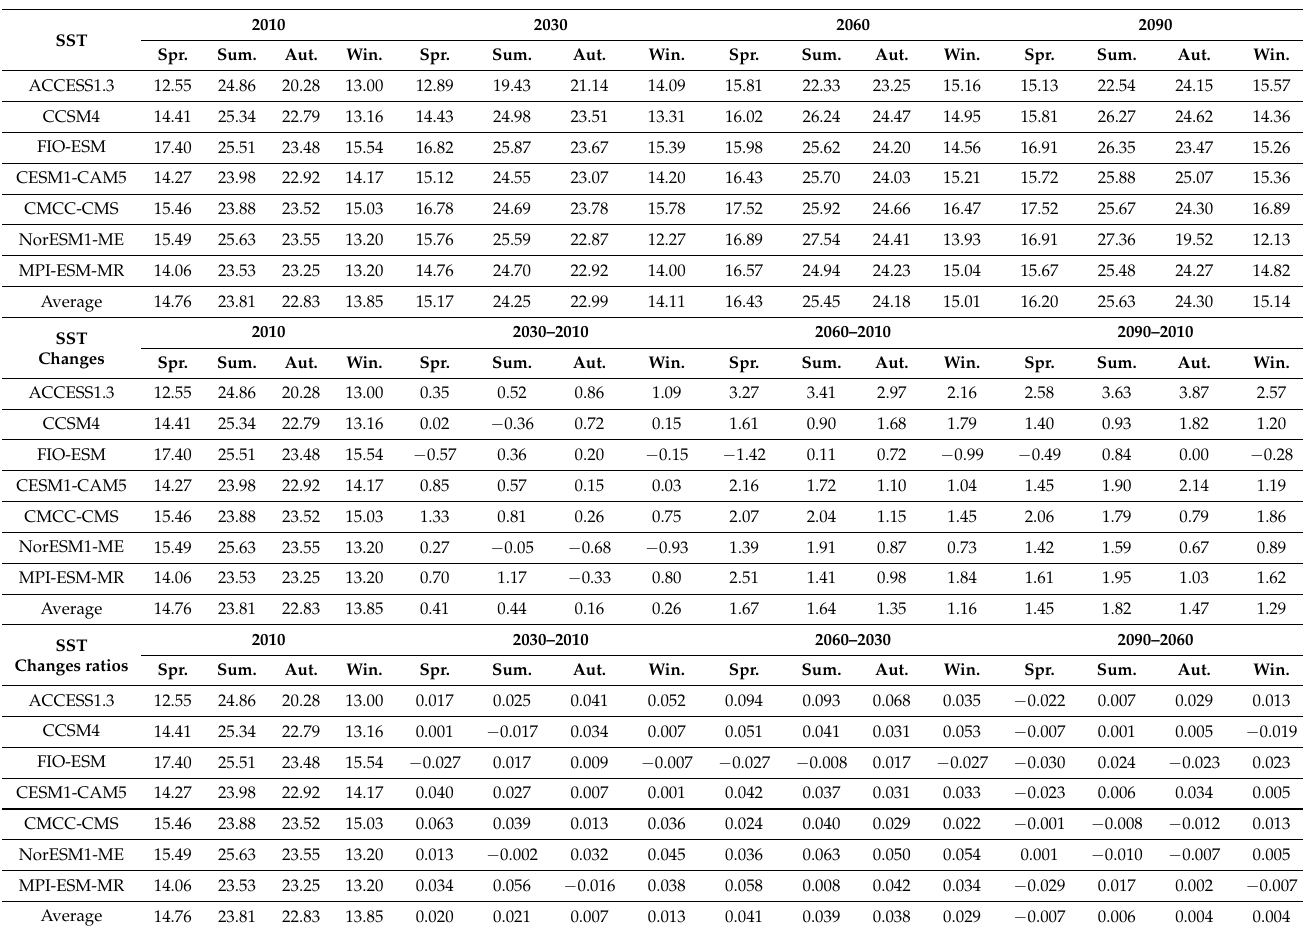
Table A2. The projection results of seasonal SST variations in the next 100 years using seven CMIP5 models and their average result using the raw CMIP5 model data without projection result